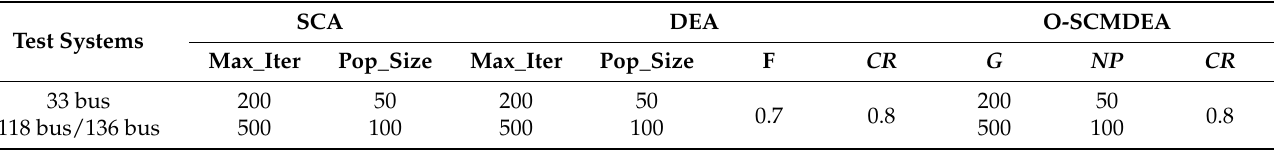
Table 3. Control parameter setting of the SCA, DE and O-SCMDEA for the different test systems. Test